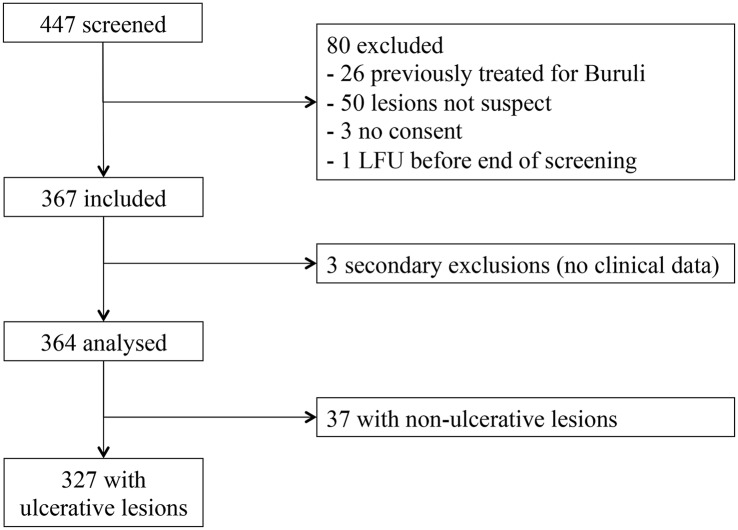
Patient flow, Buruli score study 2011–2013, Akonolinga, Cameroon.